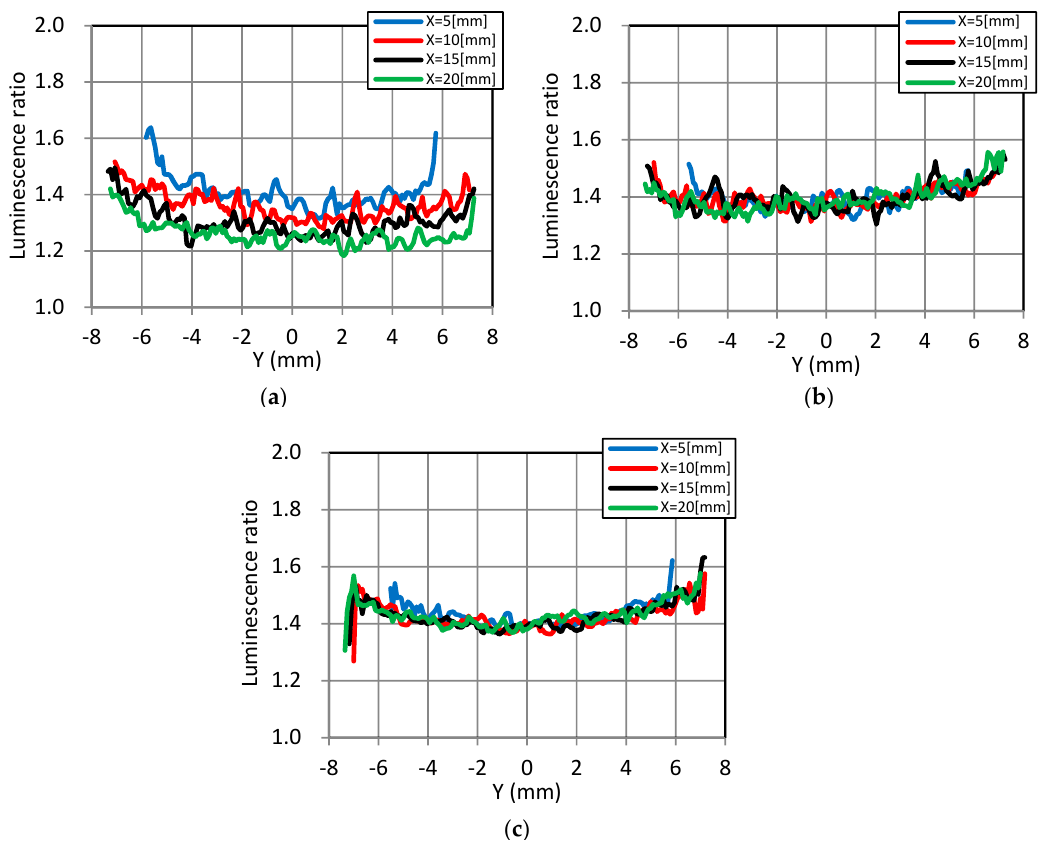
Figure 10. Luminescence ratio plots along the Y-axis (circumference direction). ( a ) Static dipping; ( b ) Convectional dipping; ( c ) Rotational dipping.